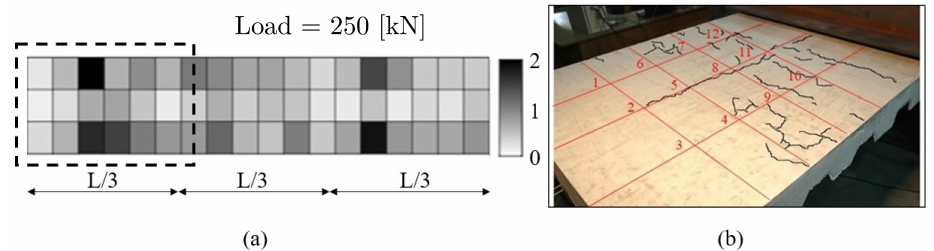
Figure 14. ( a ) Whole beam with damage indices computed with the present numerical approach. ( b ) Experimentally measured crack pattern. (left) Area on the right